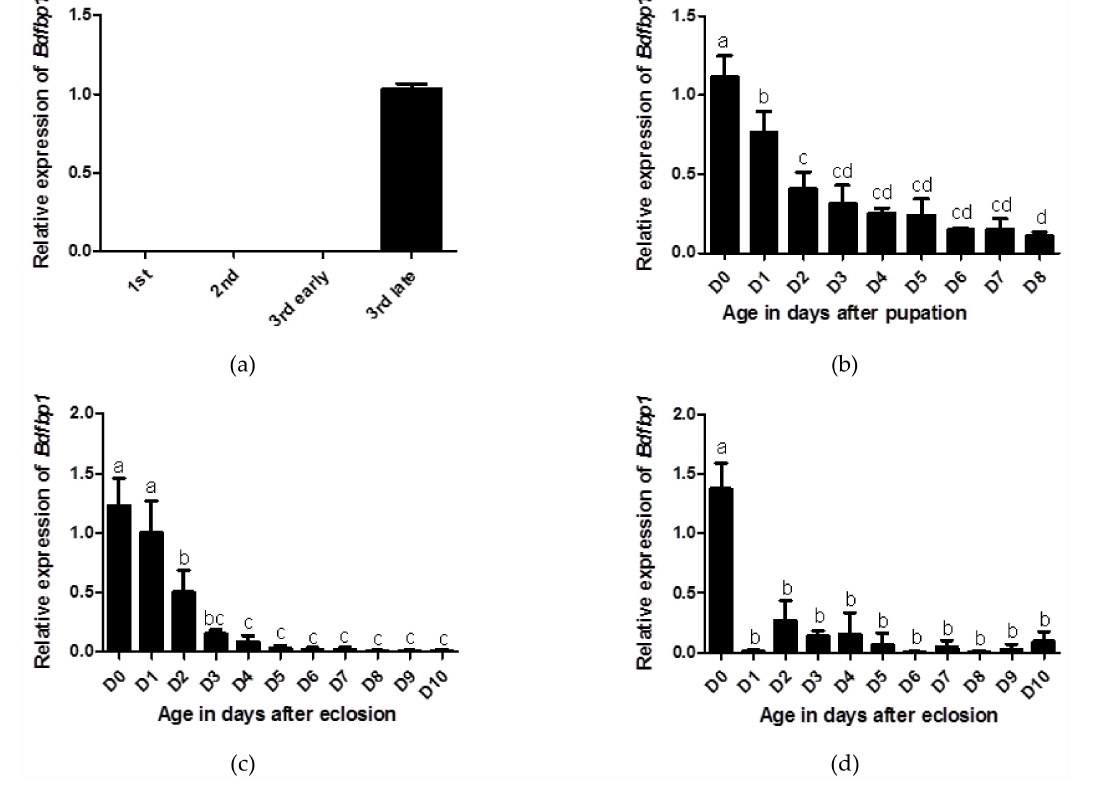
Figure 5. Developmental profiles of Bdfbp1 transcription were determined through qPCR. ( a ) larval stage: first, second, early third, and late third instar; ( b ) pupal stage: 0–8 days after pupation; ( c ) adult female fat body, and ( d ) adult male fat body: 0–10 days after eclosion. Statistical analyses using ANOVA followed by a Tukey multiple comparison test were performed to identify differences between individual means. The same letters indicate no significant difference ( p > 0.05). Standard deviation of three independent biological replicates is indicated by error bars in ( a – d